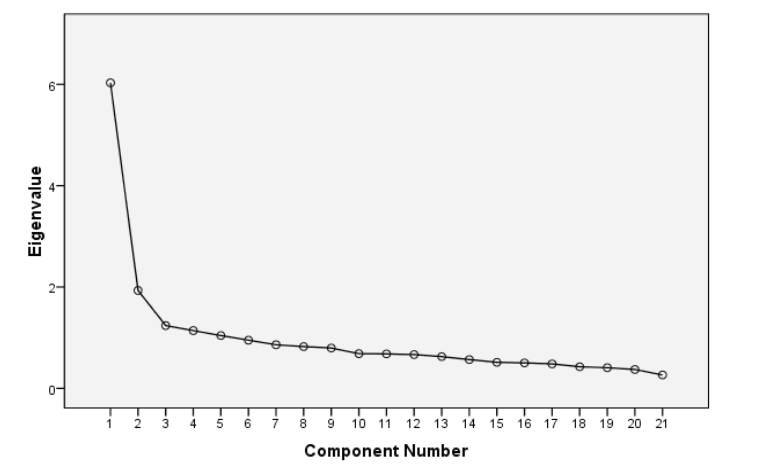
Figure 1 . Scree plot of items in the cognitive hope